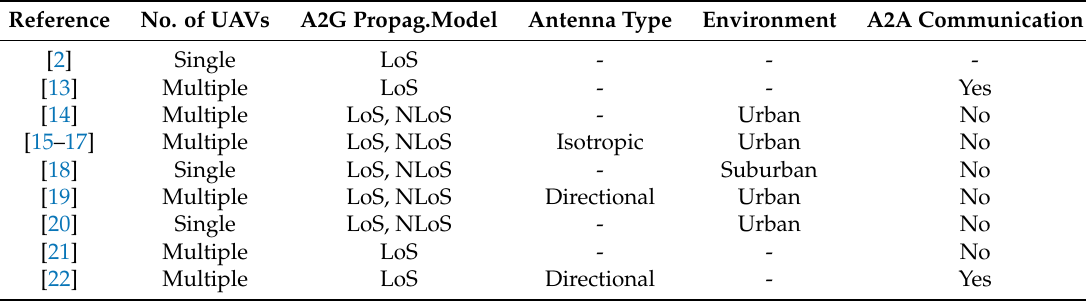
Table 1. Main characteristics of the related work on UAV placement